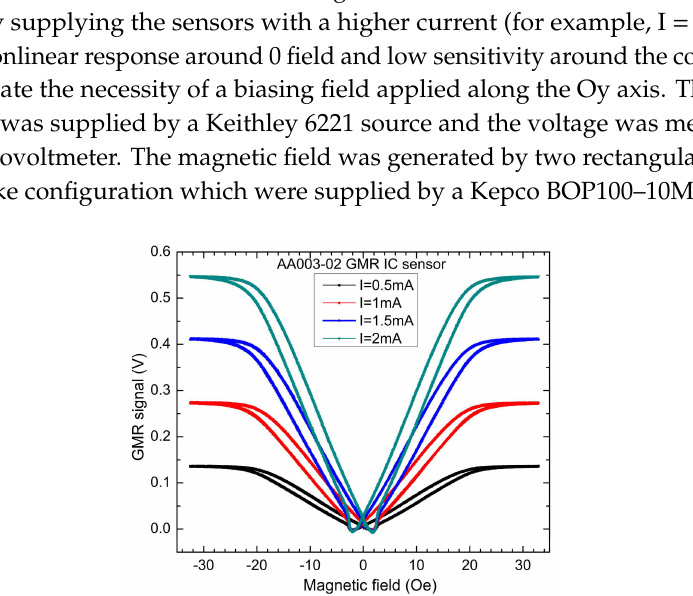
Figure 4. Typical measured field dependencies of the output signal for AA003-02 GMR sensor for di ff erent driving currents.